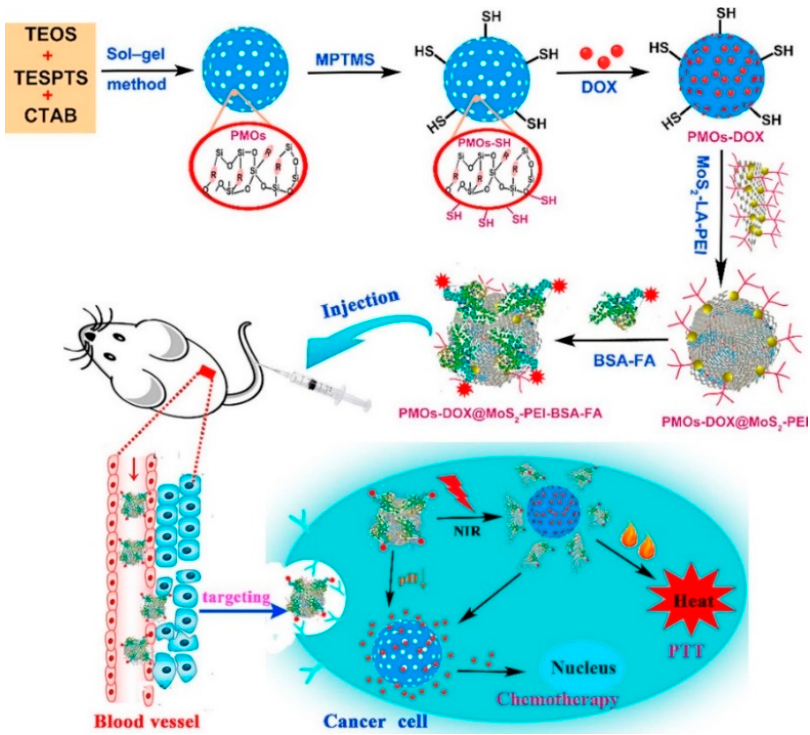
Figure 6. Schematic illustration for the synthesis and preparation of PMO–DOX@MoS 2 – lipoic